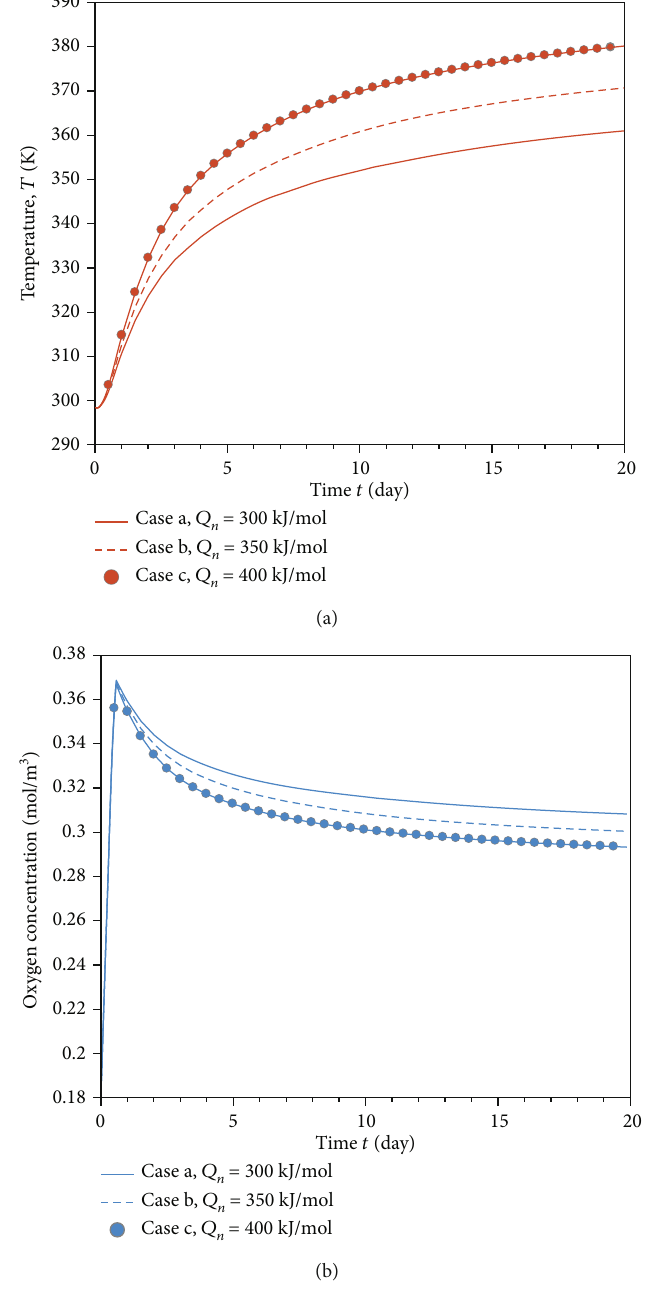
Figure 8: The evaluation of temperature and oxygen concentration with di ff erent values of coal-oxygen reaction heat. Table 2: Di ff erent values of activation energy.